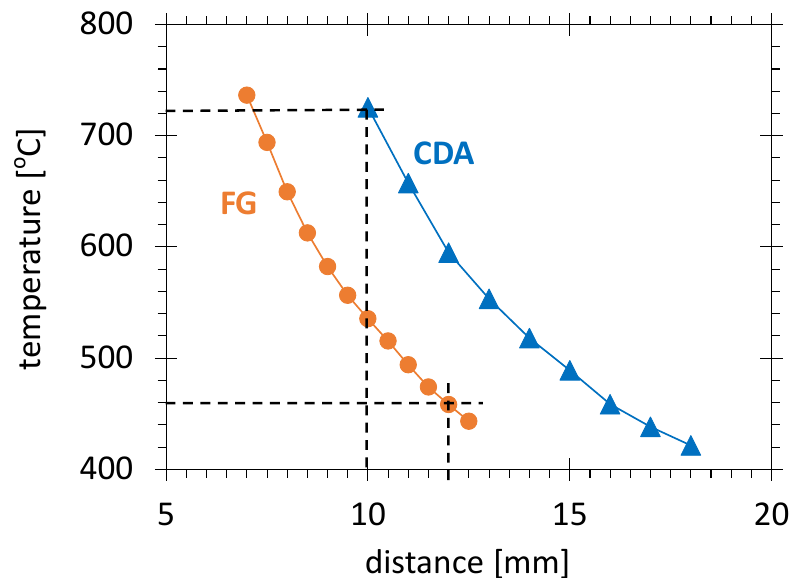
Figure 13. The static temperature measured in the FG95/5 and CDA plasma jet, for an HV pulse frequency of 56 kHz and a gas flow of 40 SLM.